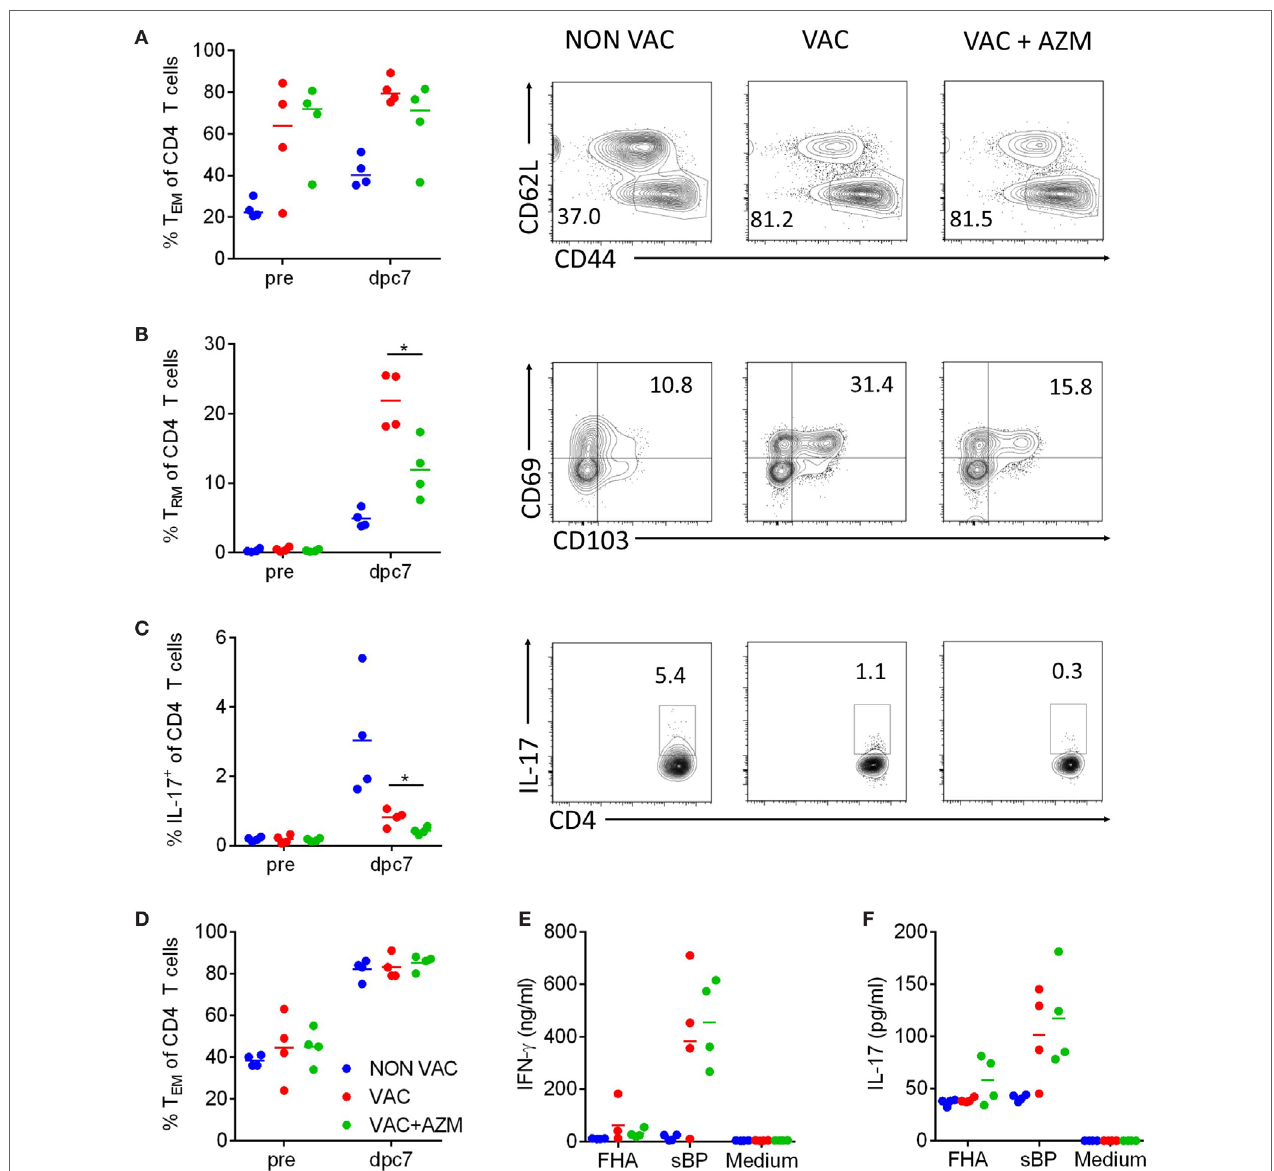
FigUre 5 | Azithromycin (AZM) treatment during immunization modulates CD4 T cell responses. Mice received AZM or vehicle during immunization with whole cell pertussis vaccine 6 and 2 weeks before aerosol challenge with Bordetella pertussis . CD4 T cells were analyzed in lung homogenates 1 day before (pre) and 7 days post challenge (dpc) via flow cytometry. The percentage of T EM (CD62L low CD44 + ) (a) , tissue-resident memory T (T RM ) (CD62L low CD44 + CD69 + CD103 + ) (B) , and IL-17-producing cells (c) in the CD4 population in the lung were determined. Representative dot plots of the CD4 + population (a,c) and the T EM population (B) are shown. Splenocytes were generated 1 day before (pre) and on 7 dpc and analyzed via flow cytometry. The percentage of T EM cells (D) within the CD4 population was determined. Splenocytes were stimulated with filamentous hemagglutinin (FHA) or sBP for 72 h. IFN- γ (e) and IL-17 (F) production in the supernatants were determined via ELISA. Four mice per group and timepoint, horizontal lines indicate mean. Significances were determined via t -test comparing the VAC and VAC + AZM group, * p <